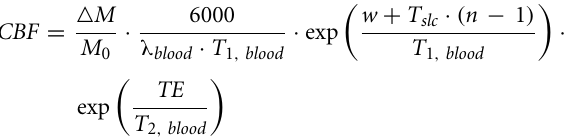
study cardiorespiratory fitness (eCRF) was estimated according to this equation (see Jurca et al.,